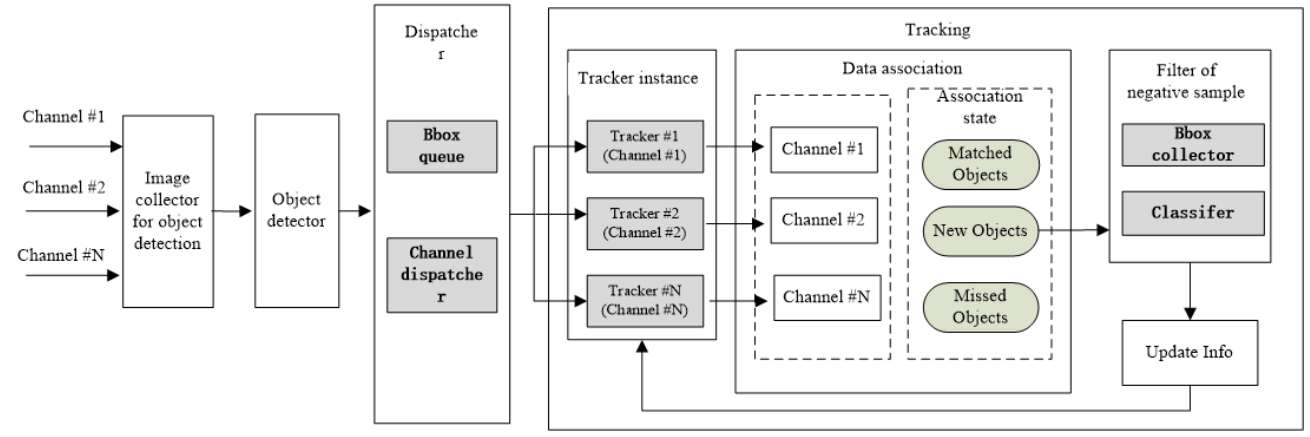
Figure 1. The multiobject tracking (MOT) framework based on multiway concurrency.